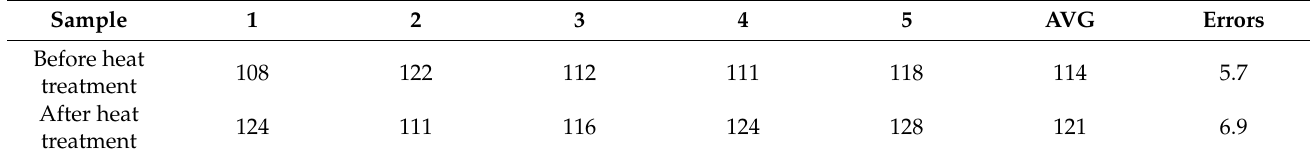
Table 2. Microhardness of non-heat-treated die-casting samples.